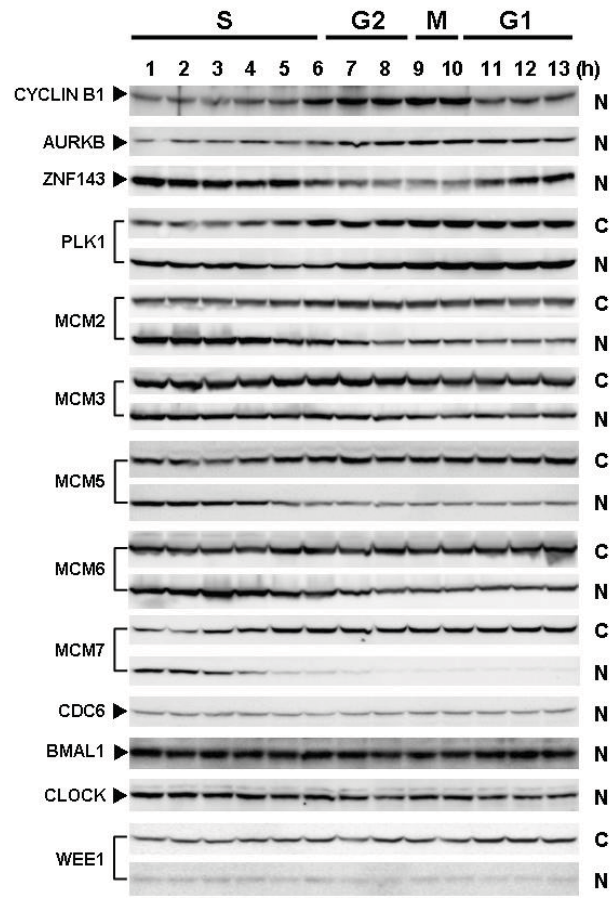
Figure 2. Fluctuations of protein expression associated with the cell cycle in PC3 cells. PC3 cells cultured for 12 h in serum-free medium were re-seeded. At the indicated times after re-seeding, cells were collected and fractionated into nucleoplasm and cytoplasm. Each cell lysate (10 0 μg) was used for Western blotting with indicated antibodies. N and C indicate nucleoplasm and cytoplasm,